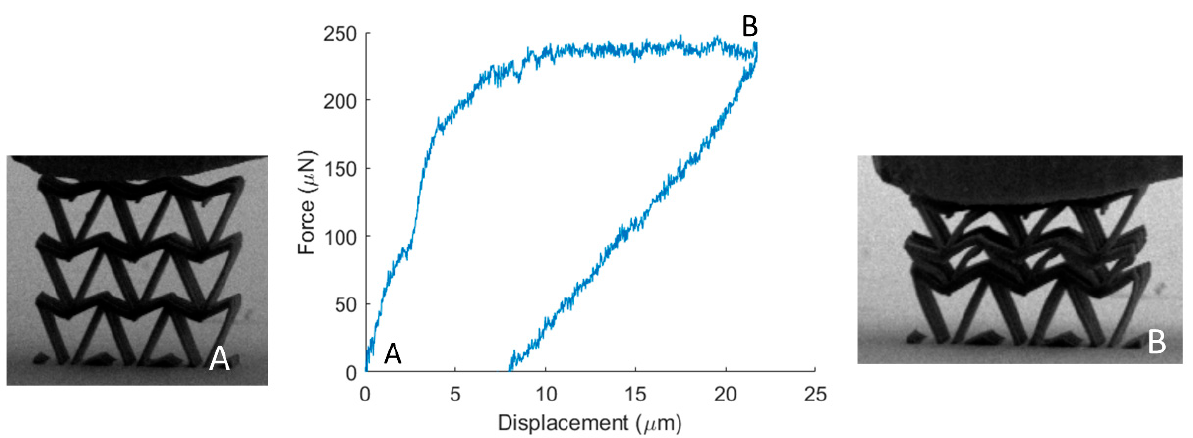
Figure 6. Mechanical testing of the re-entrant triangular filter. From stage A (undeformed configuration), the structure gets compressed, leading to the emergence of the auxetic behavior and the densification of the structure (stage B). A video of this mechanical testing is included Supplementary Information (filter.mp4).